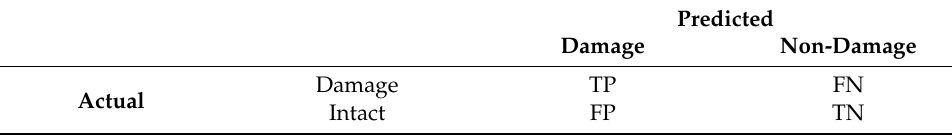
Table 4. Confusion matrix for the Damage and Intact